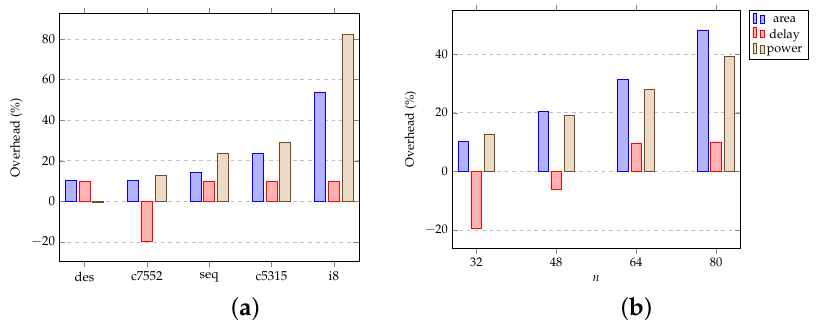
Figure 13. Overhead evaluation of SKG-Lock+: ( a ) overhead with n = 32 (benchmarks are in decreasing size order), ( b ) overhead evaluation vs. key size (benchmark is